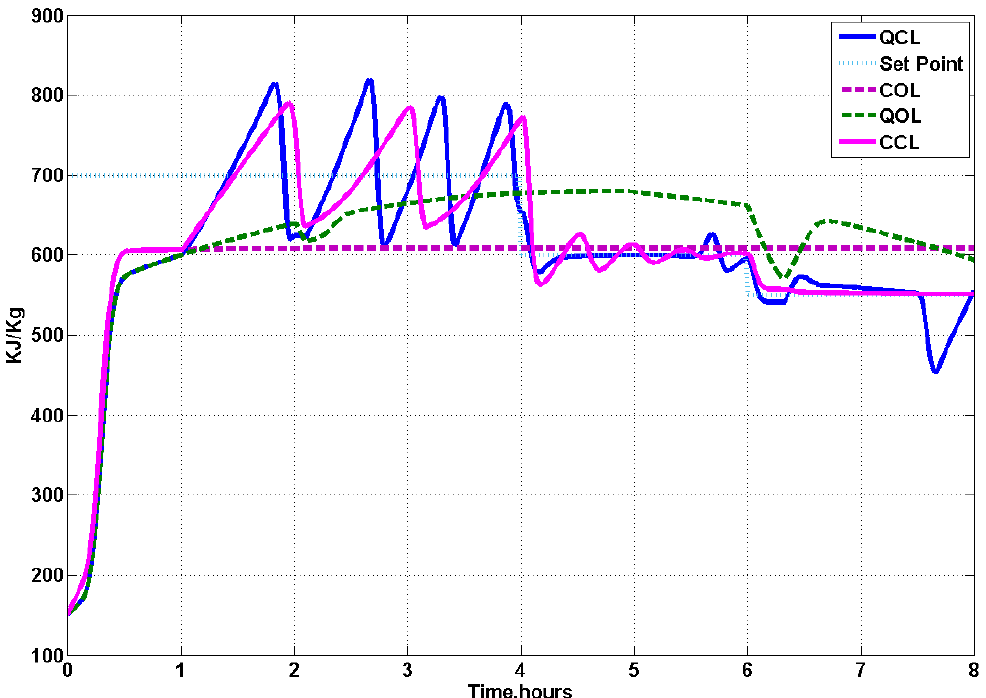
Figure 12. Enthalpy of process variables (PV) of